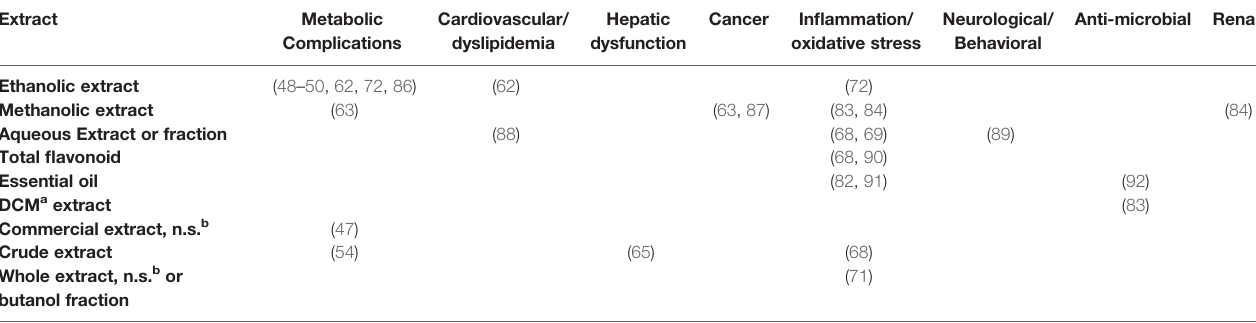
TABLE 2 | In vitro and in vivo studies of A.